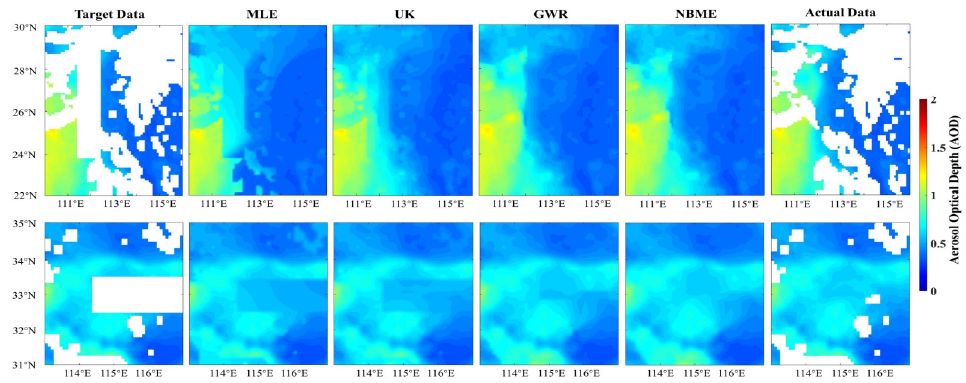
Figure 5. Comparison of the actual AOD data and the recovered results of two detailed